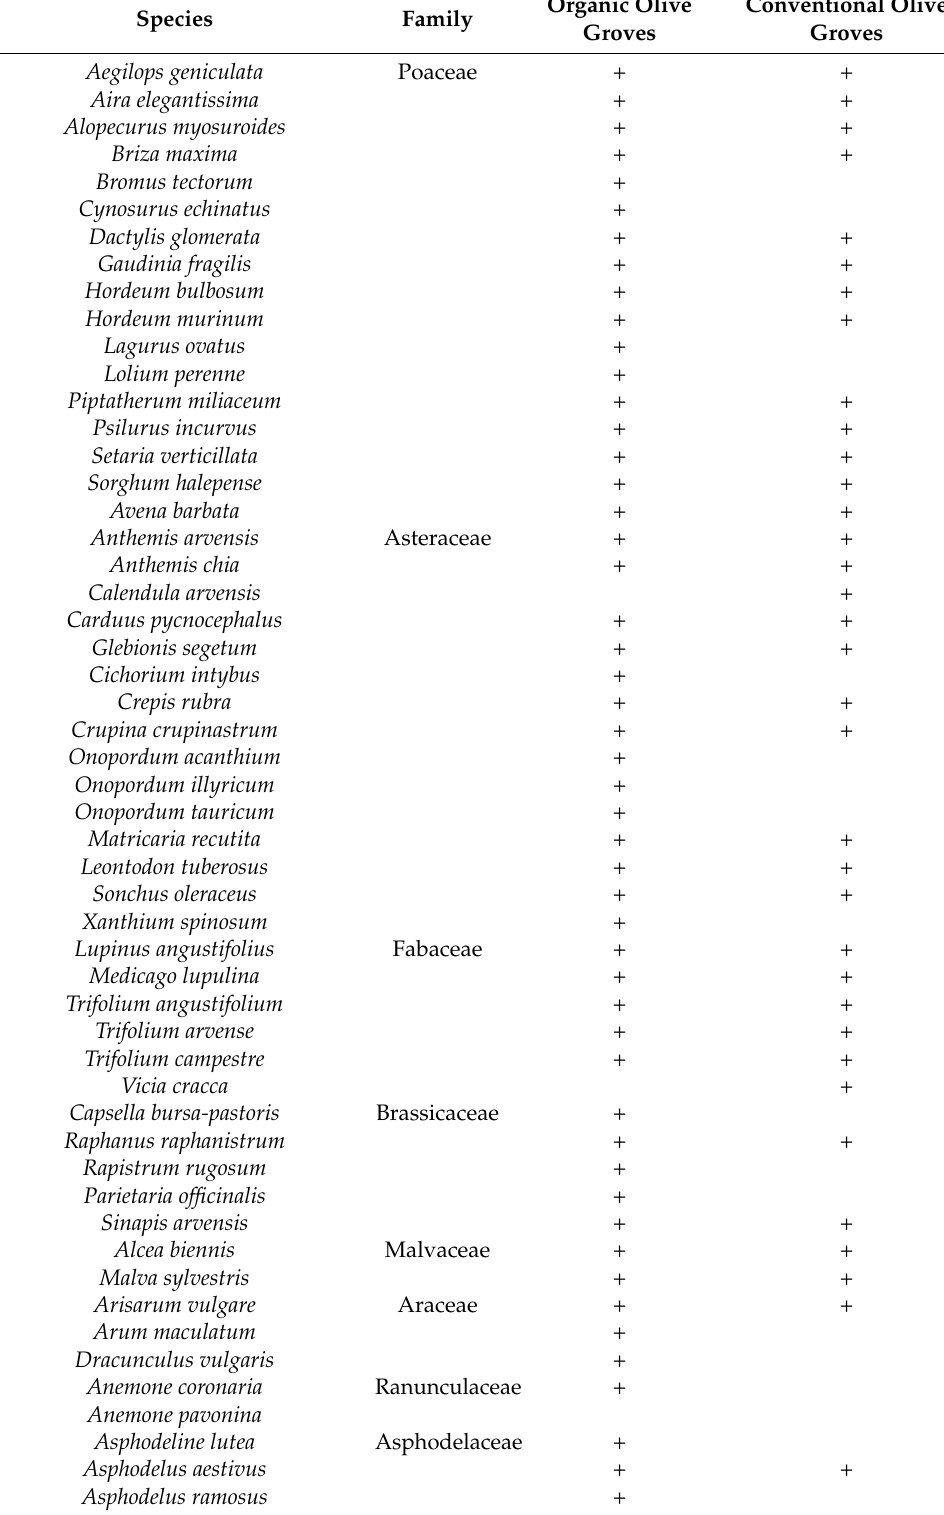
Table A2. Herbaceous plant species recorded in organic and conventional olive groves. Species nomenclature based on Dimopoulos et al. (2013; 2016)